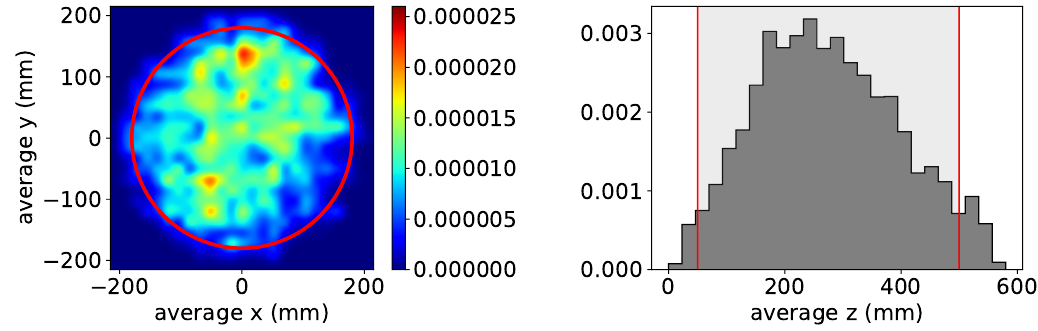
Figure 4 . Normalized distributions in x - y (left) and z (right) of observed energy depositions for events in the 2615 keV 208 Tl photopeak (data from run 6485). The solid red lines show the (cid:12)ducial cuts employed in this study which encompass nearly the entirety of the active volume. Note that the (cid:12)ducial cuts are placed on all reconstructed energy depositions, rejecting an event if one or more depositions occurred outside the